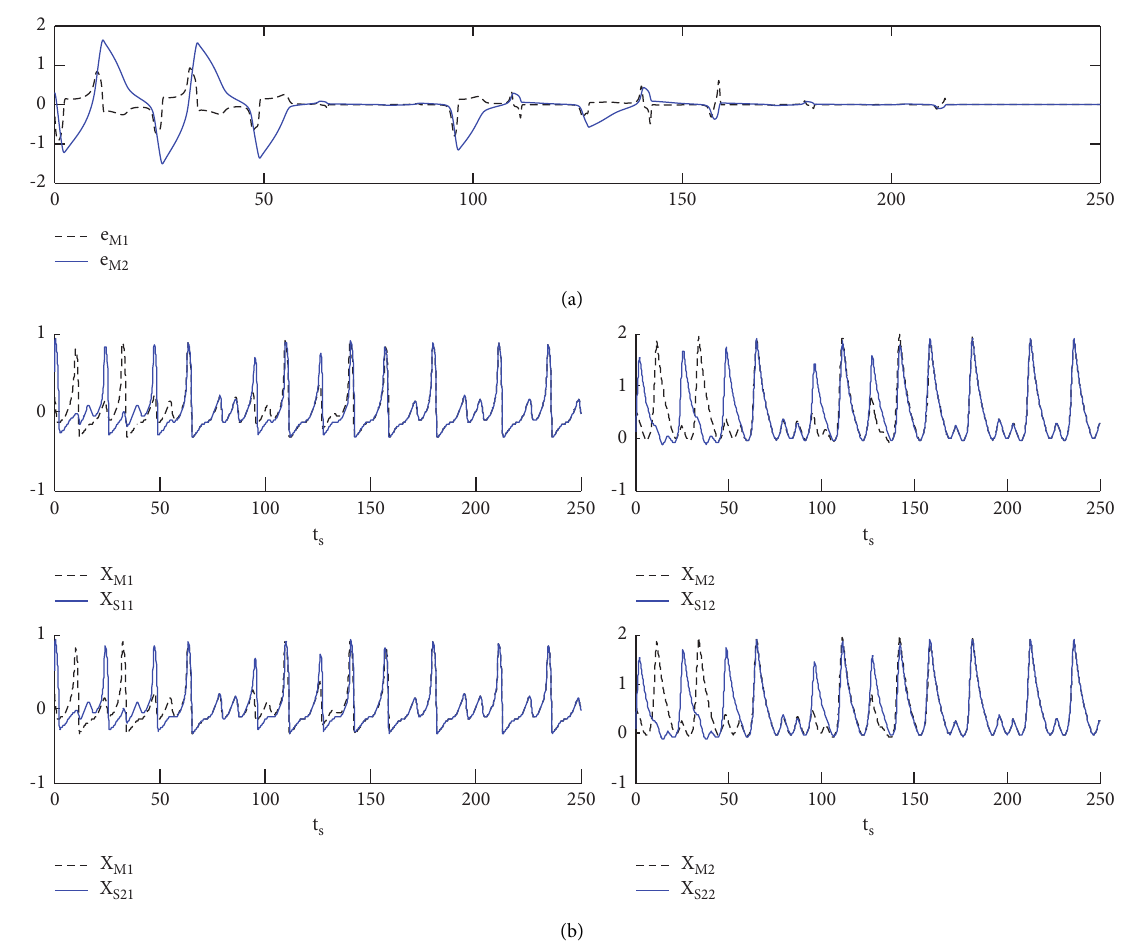
Figure 5: (a) Master and slave systems and (b) their respective observer recovery variables of Theorem 1.